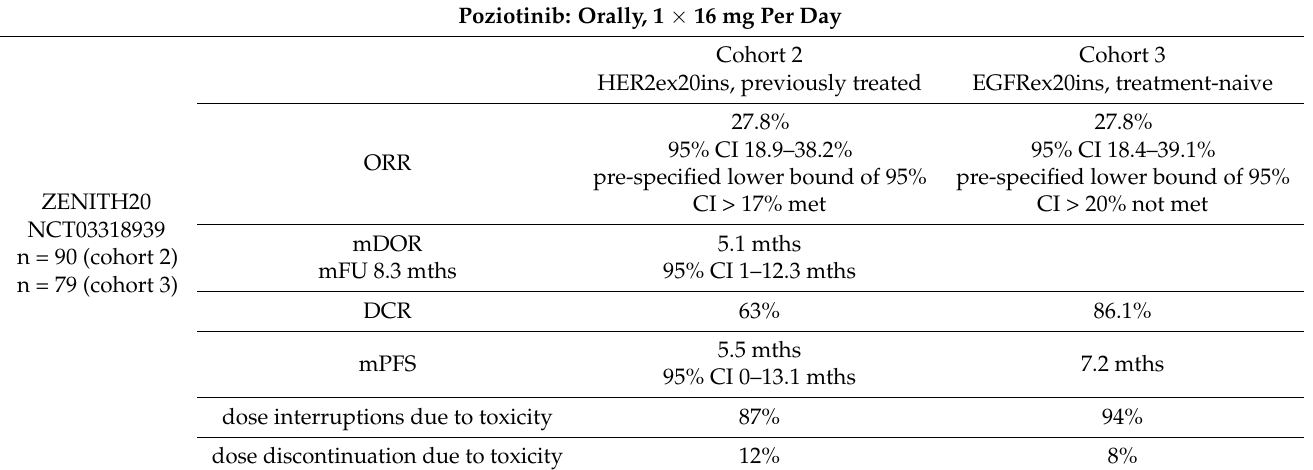
Table 3. Detailed results of the ZENITH 20 study for cohorts C2 and